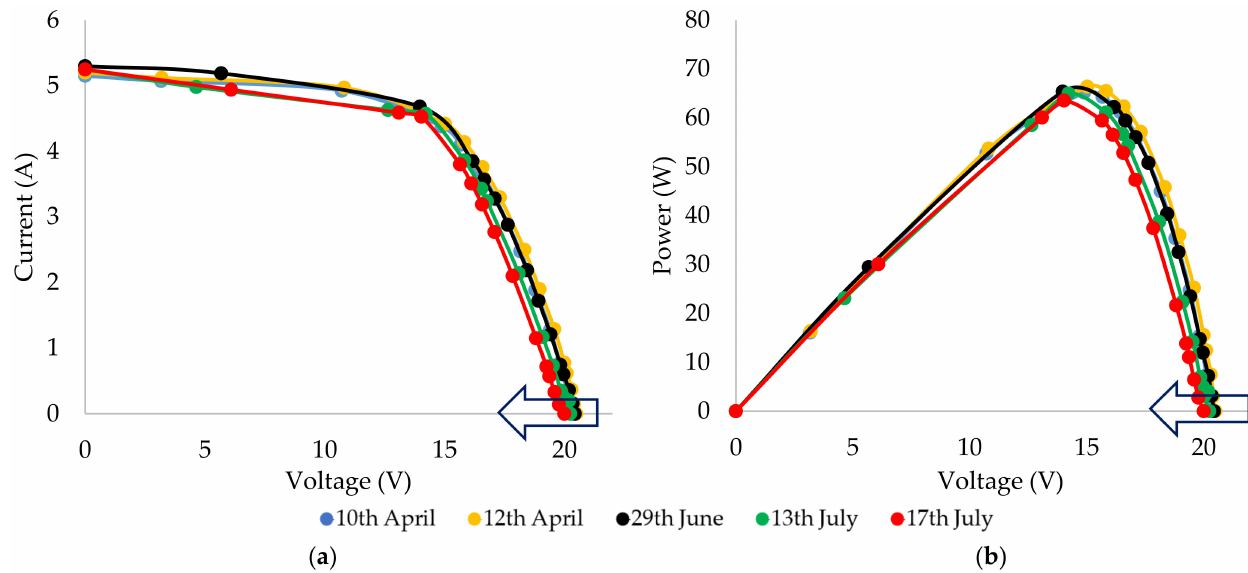
Figure 8. I-V and P-V curves for PV panel P2. ( a ) Temperature effect on P2 and the IV curves behavior at 900 W/m 2 with different ambient temperatures, ( b ) Temperature effect on P2 and the PV curves behavior at 900 W/m 2 with different ambient temperatures (see the Table 1).